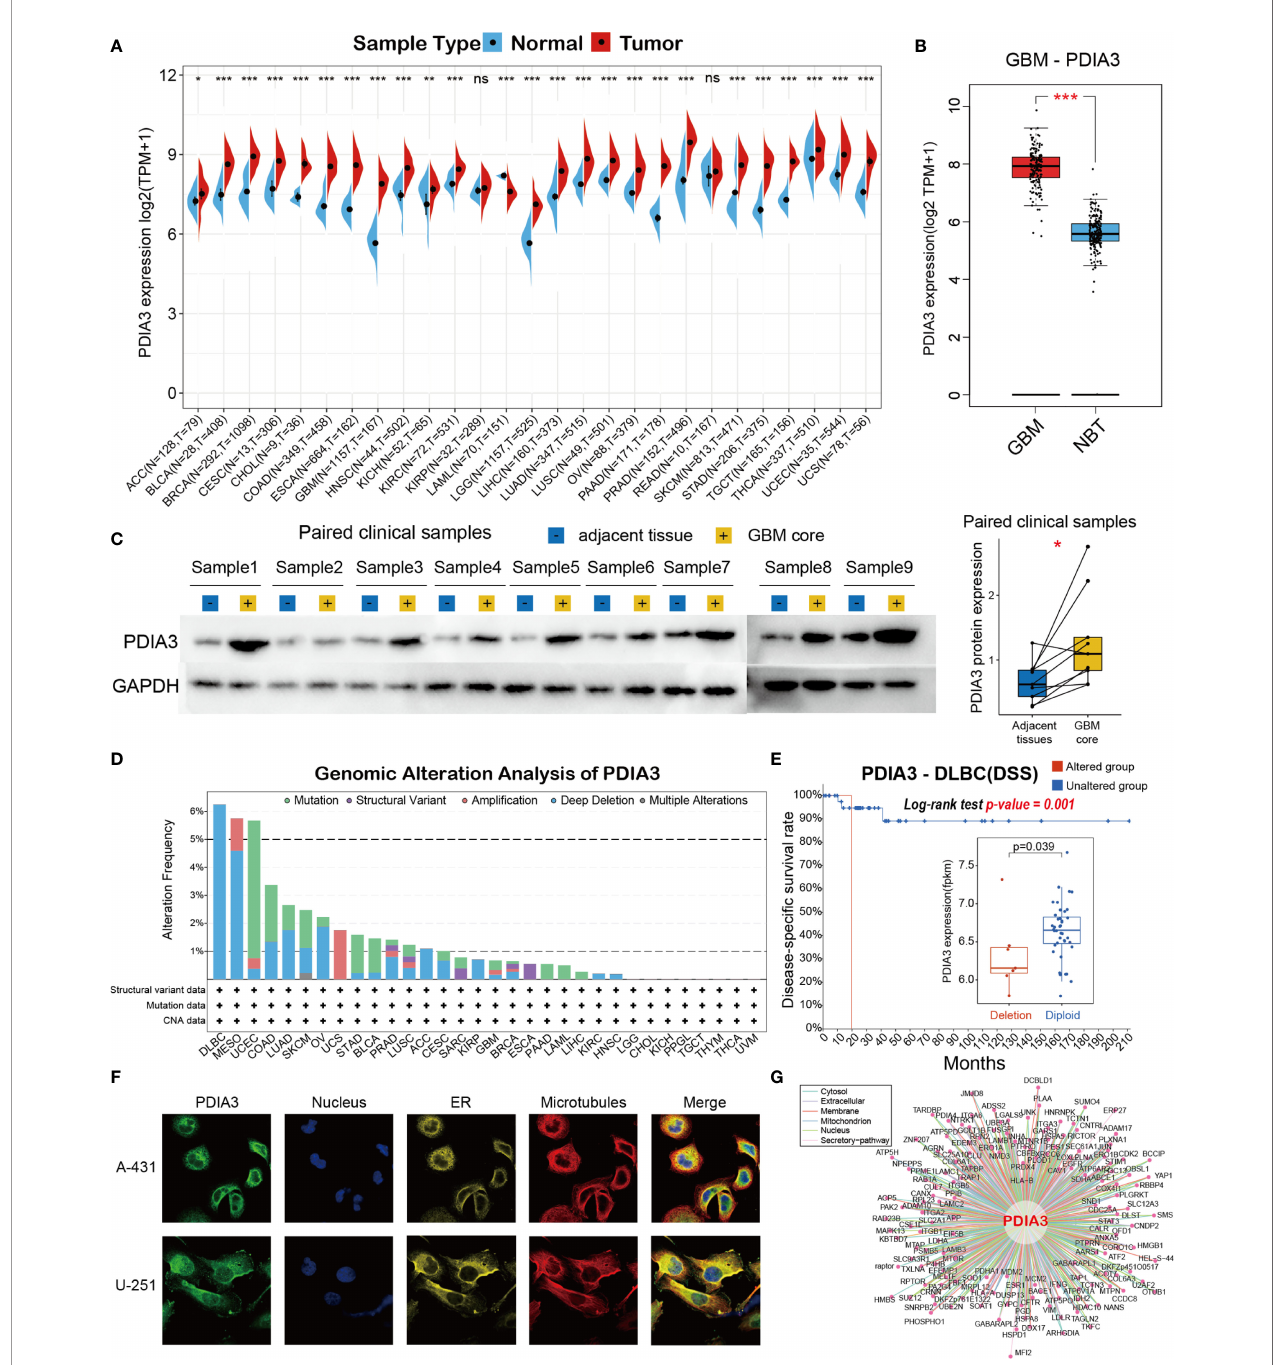
FIGURE 1 | Basic information of PDIA3. (A) The expression level of PDIA3 between tumor and normal tissues in each cancer based on the integrated data from TCGA and GTEx datasets. (B) The expression level of PDIA3 between GBM and normal brain tissues. (C) Western blot protein detection of the PDIA3 expression levels in paired GBM and adjacent normal tissues. (D) PDIA3 alteration frequency analysis in pan-cancer study according to the cBioPortal database. (E) The PDIA3 expression levels and prognosis of DSS between PDIA3-deletion and diploid DLBC patients. (F) The immuno fl uorescence images of PDIA3 protein, nucleus, endoplasmic reticulum (ER), microtubules and the merged images in A-431 and U251 cell lines. (G) The protein-protein interaction (PPI) network presents the proteins interacting with PDIA3. The labelled asterisk indicated the statistical p value (ns p > 0.05, *p < 0.05, **p < 0.01 and ***p < 0.001). ns,